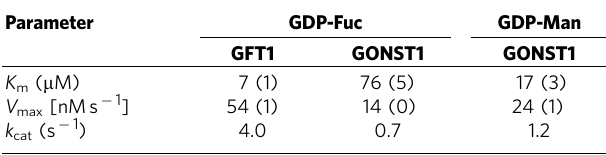
Figure 4 | Concentration- and time-dependent transport activities for GFT1. ( a ) Proteo-liposomes, pre-loaded with 10mM GMP, were incubated with GDP-Fuc at varying concentration (0.5–400 m M) for 2min at 25 (cid:2) C. ( b ) Proteo-liposomes, pre-loaded with 10mM GMP, were incubated with GDP-Fuc at a concentration of 50 m M for the indicated time points at 25 (cid:2) C. Values are normalized to the actual NSTcontent present in proteo-liposome preparations (Supplementary Table 1). Data are the mean and s.e.m. of n ¼ 4 assays.